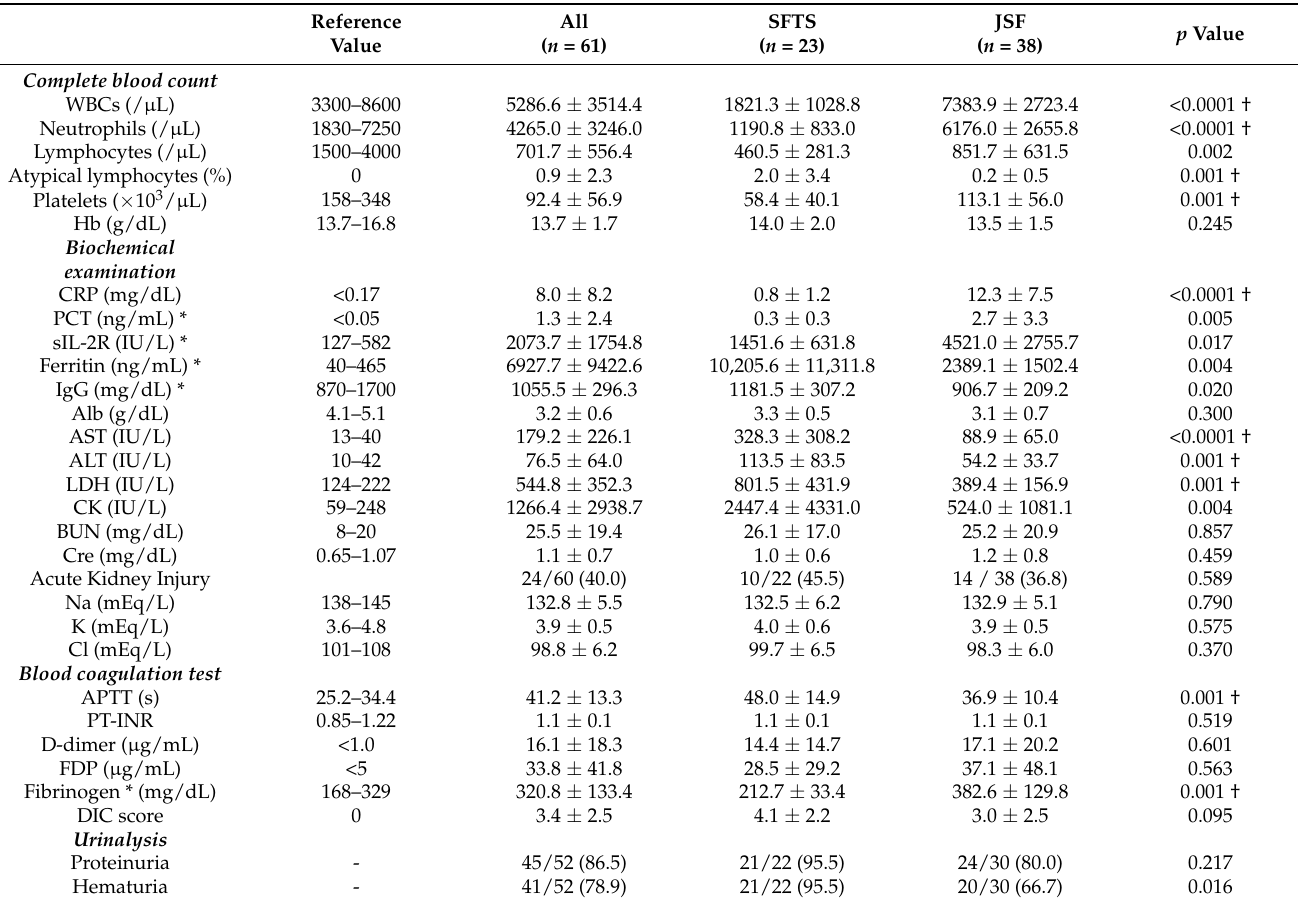
Table 3. Laboratory findings on admission in patients with SFTS or